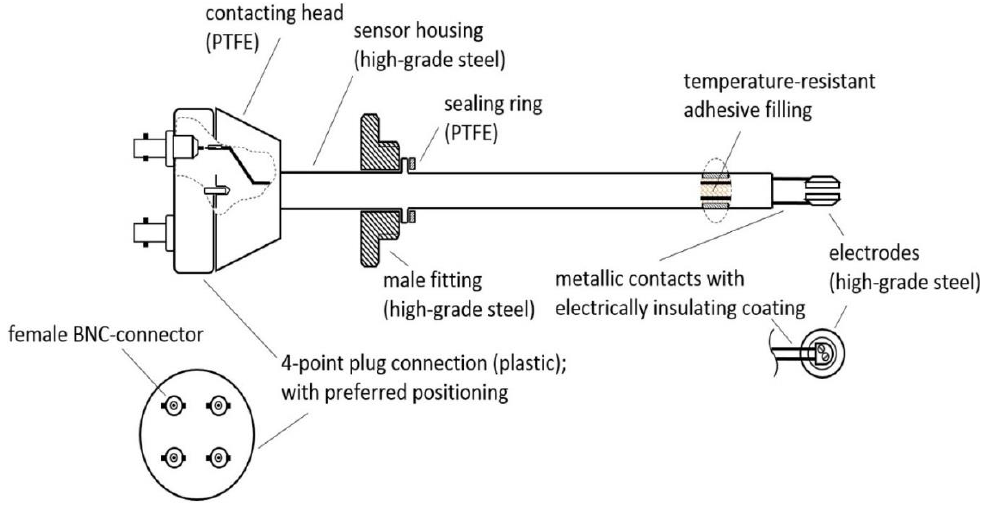
Figure 1. Sketch of the inline probe prototype indicating used materials and wiring. Connection to the impedance analyzer was performed using a four-point BNC (Bayonet Neill–Concelman)